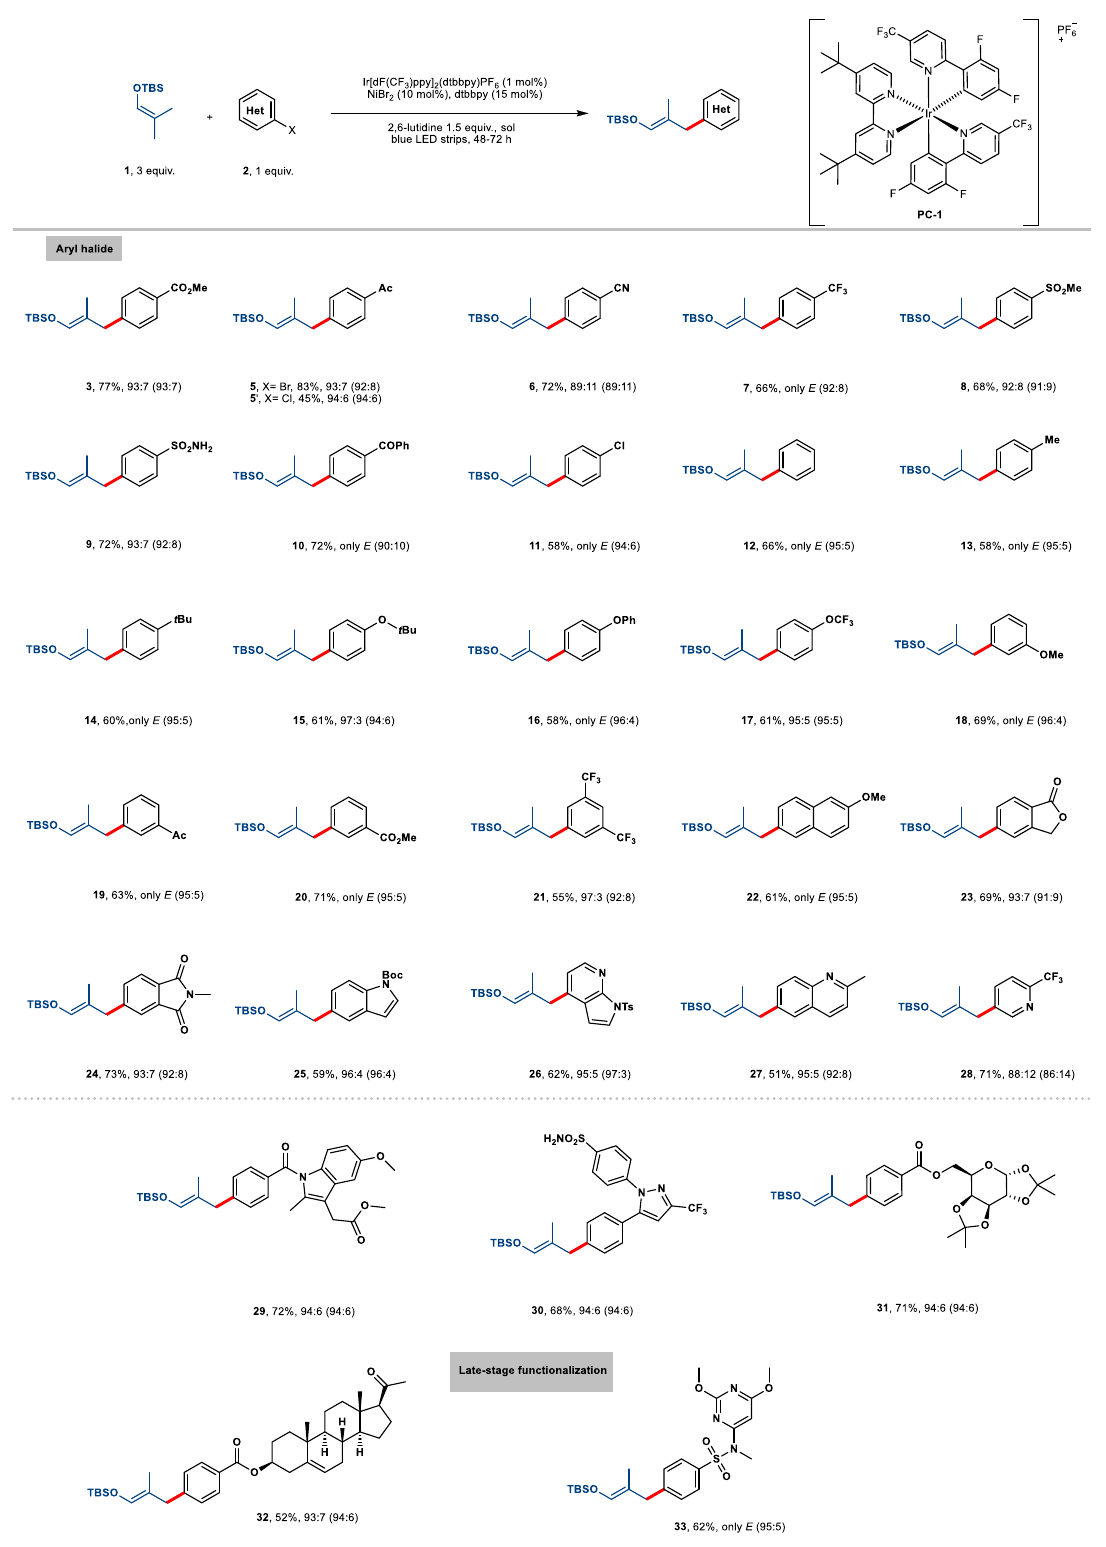
Fig. 2 | Scope for the formation of E isomer with aryl halides. Unless otherwise speci fi ed, the reactions were performed on a 0.2mmol scale under the following reaction conditions: 1 (3 equiv.), aryl halide (1 equiv.), 2,6-lutidine (1.5 equiv.), PC-1